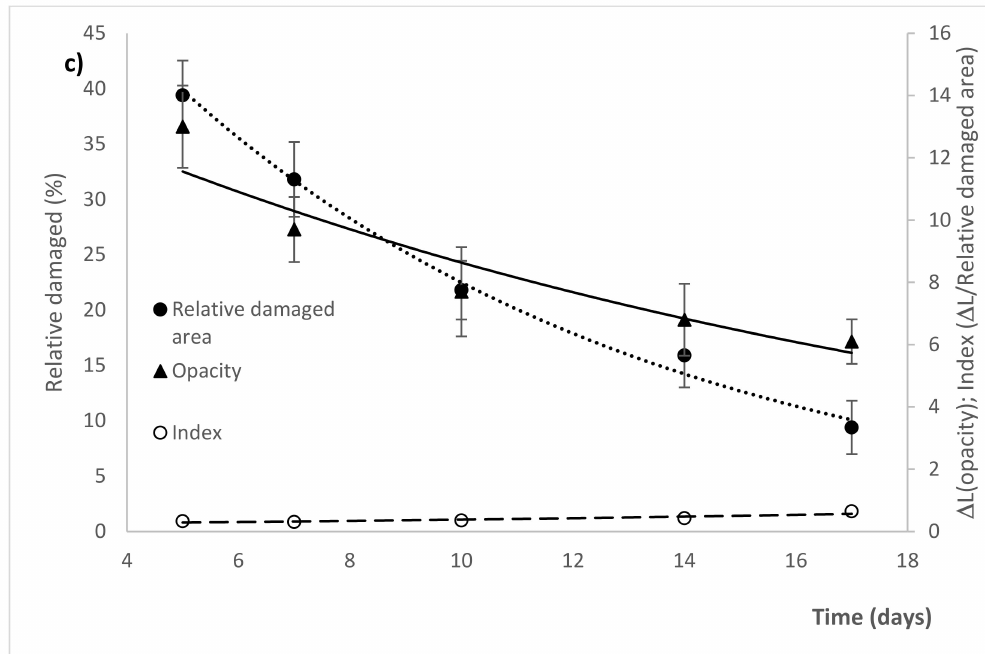
Figure 6. Representation of the time course of changes in relative damaged area, ocular opacity, and the index that relates the opacity and the relative damaged area. Negative control group in panel ( a ), ( (cid:78) ) y = 1173.35e − 0.277x , ( • ) y = 10.00e 0.016x , ( ) y = 0.057e 0.243x . Positive control in panel ( b ), ( (cid:78) ) y = 7.984e 0.028x , ( • ) y = 140.09e − 0.183x , ( (cid:35) treatment in panel ( c ), ( (cid:78) ) y = 15.48e − 0.058x , ( • ) y = 70.68e − 0.115x , (